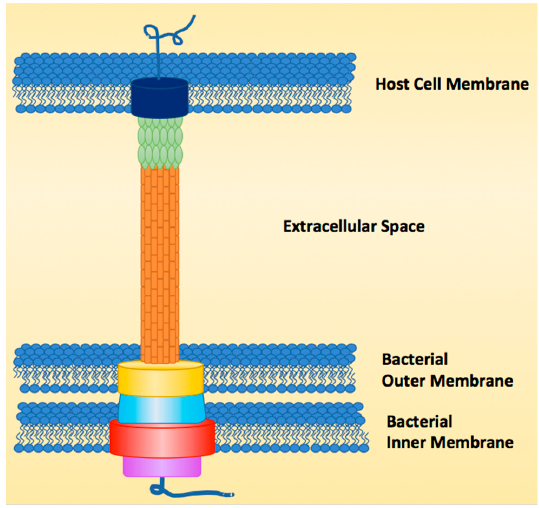
Figure 1. Example of type III secretion system (T3SS) structure.